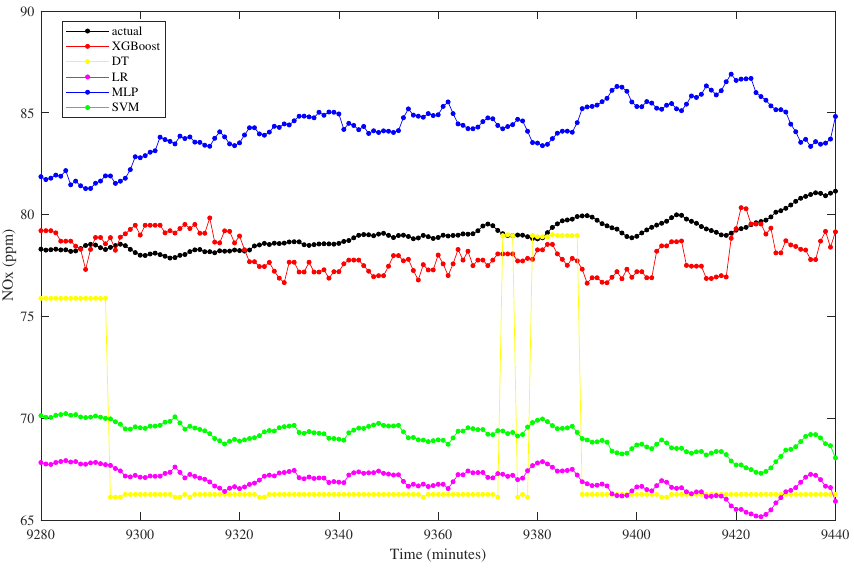
Figure 12. NO x prediction from different algorithms.